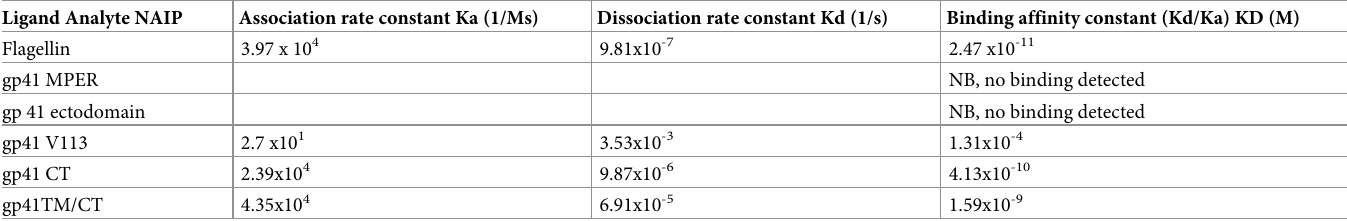
Table 1. Binding constants of gp41 domains to NAIP. The binding affinity is expressed as KD. Ligand Analyte